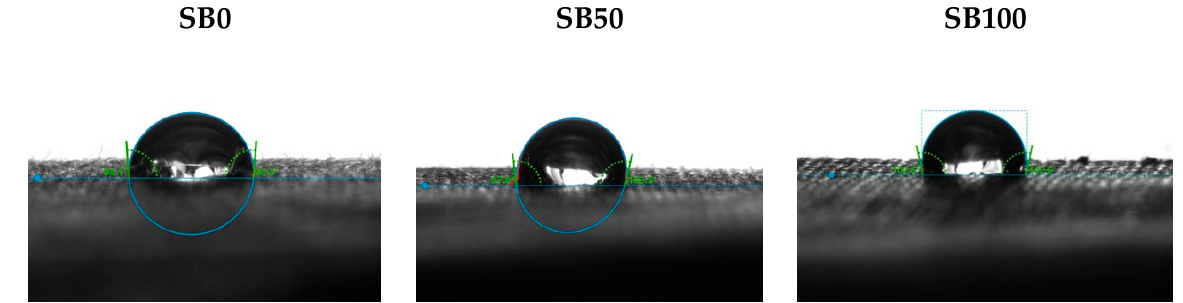
Figure 2. DSA images for samples without binder.